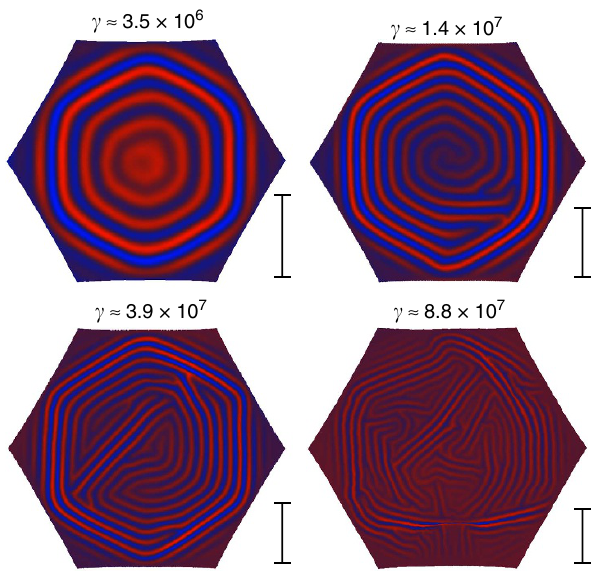
Figure 5 | Domain size scaling. Typical equilibrium wrinkle patterns in a hexagonal section of a thin spherical shell on a liquid substrate. All simulation parameters are kept fixed, except for the sheet thickness. The Figure 4 | Undulation instability. ( a ) Equilibrium wrinkle patterns in a flat Fo¨ppl–von Ka´rma´n number g of the system is indicated above each pattern. thin ribbon residing on a flat body of water (simulation), held at its far ends While the top-left pattern is clearly divided into six domains, increasing g with a fixed wavy boundary. The preferred wrinkle wavelength l 0 is seems to decrease the typical domain size. The scale bar to the right of 5% shorter than the boundary wavelength l B . Shown are the results for each pattern shows the scaling of typical domain sizes predicted by ffiffiffiffiffiffiffiffiffiffiffi l p various values of the predicted undulation wavelength l pred equation (20), up to a constant factor (only the ratios between bars are pen d und ¼ (equation (19)), where the ribbon’s width is used as a surrogate for the meaningful since equation (20) suggests only the scaling of the typical size system scale d . ( b ) The measured undulation wavelength is plotted against and leaves the prefactor unknown). the predicted one. While corroborating the predicted scaling, the measured wavelength is consistently larger than ffiffiffiffiffiffiffiffiffiffiffi l pen d p by a factor of E 1.7, suggesting that the relevant system scale d may be different than the ribbon width by a constant factor. ( c ) Simulation results for a spherical cap with free boundary conditions. An undulation appears spontaneously, and its observed wavelength (black triangles) agrees with the predicted value, where the shell’s diameter appears to be a good surrogate for the system scale d geometric incompatibility. The coarse-grained metric g (cg) of a domain-type patterns is approximately that of a piecewise-linear configuration that approximates the curved target metric g ð eff Þ .